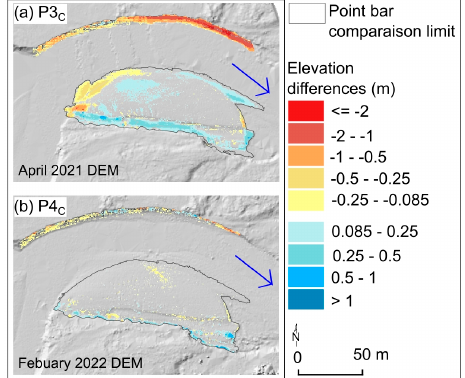
Figure 5. Altitudinal differences on the bank and the point bar at Site 2 for ( a ) the period P3 C and ( b ) the period P4 C . The blue arrow indicates the flow direction.